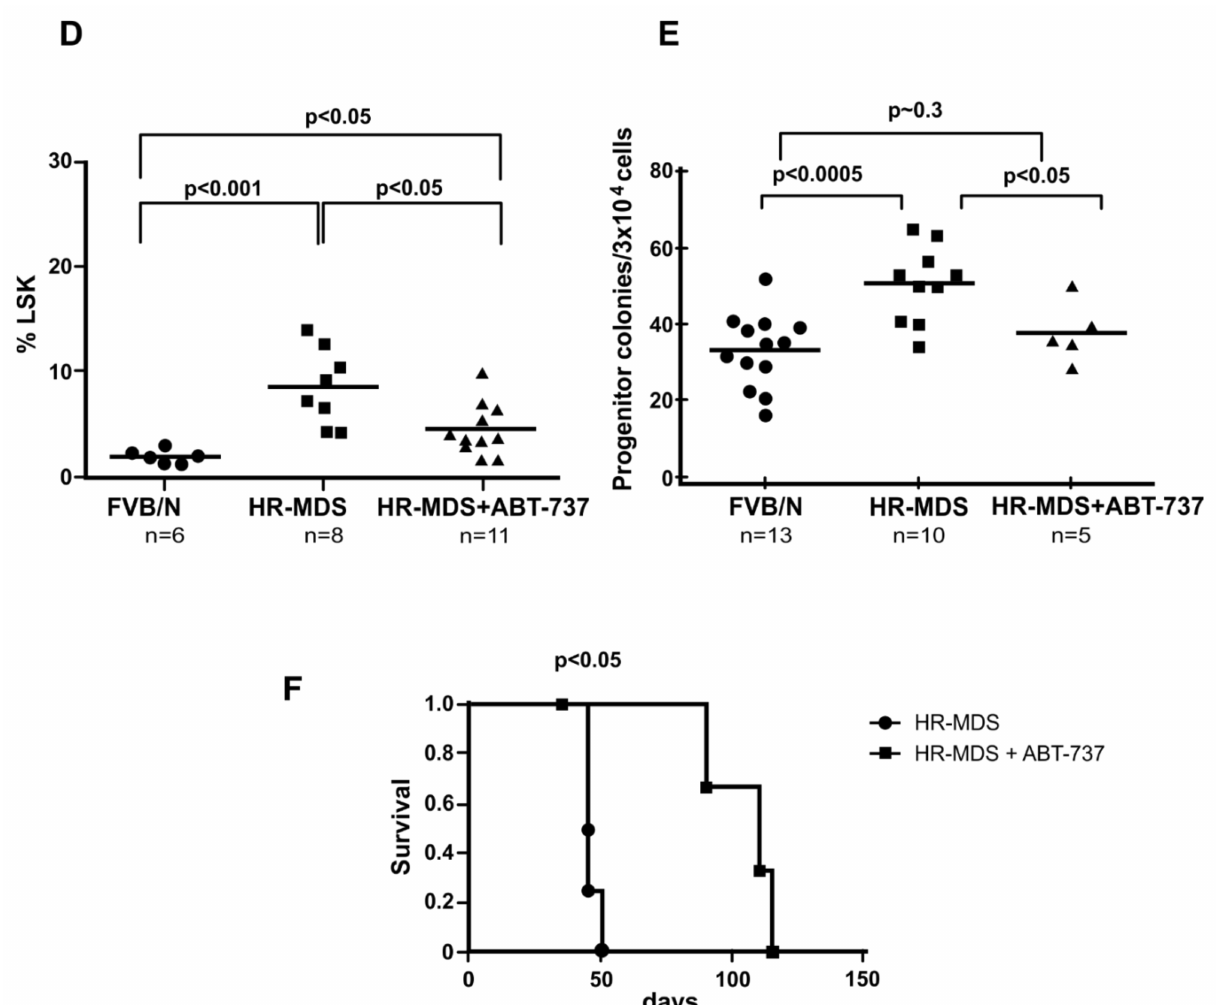
Figure 1. ABT-737 rescues clinical features of HR-MDS mice. ( A ) Kaplan–Meier survival curves showing prolonged survival of ABT-737 treated HR-MDS mice ( n = 30), and untreated HR-MDS mice ( n = 34) plotted from date of diagnosis ( p = 0.0029) (left) and with the treatment group split into completers ( n = 21) and non-completers ( n = 9) showing a significant difference between the completers and the untreated control group ( p < 0.0001) and no significant difference between the non–completers and the controls (right) ( p = 0.3125); ( B ) White blood cell (WBC) counts; no significant differences were observed between normal FVB/N ( n = 32), untreated HR-MDS ( n = 47), pretreated ( n = 12) and post-treated ( n = 12) diseased mice; ( C ) Percentage of HR-MDS BM blast pretreatment vs. post-treatment 33 days after the start of the treatment ( n = 3 mice in untreated HR-MDS group, n = 4 mice in treated HR-MDS group). Giemsa stained BM smears showing decreased marrow blasts after treatment (shown in low power [LP 50 × ] magnification; ( D ) Lin-/Sca-1 + /c-Kit+ (LSK) cell population of normal FVB/N ( n = 6) vs. untreated HR-MDS ( n = 8) vs. treated HR-MDS ( n = 11). Significant increase of untreated HR-MDS mice compared to normal FVB/N ( p < 0.001), a decrease of treated mice compared to untreated mice ( p < 0.05) and increase of treated mice compared to normal FVB/N ( p < 0.05); ( E ) Dot plots showing numbers of day 7 colony-forming unit granulocyte-macrophage per 3 × 10 4 cells plated dish from BMs of normal FVB/N mice ( n = 13), untreated HR-MDS mice ( n = 10), treated HR-MDS mice ( n = 5). Normal FVB/N vs. untreated HR-MDS p < 0.0005, normal FVB/N vs. treated HR-MDS p ≈ 0.3, untreated HR-MDS vs. treated HR-MDS p < 0.05; ( F ) Differential survival of lethally irradiated syngeneic FVB/N mice transplanted each with 10 7 spleen cells from untreated HR-MDS or treated HR-MDS mice ( n = 4 in each group, log-rank χ 2 = 4.966, p < 0.05). One mouse in the treated group was censored due to non-leukemic death at day 35 due to failure of engraftment and two untreated mice died on day